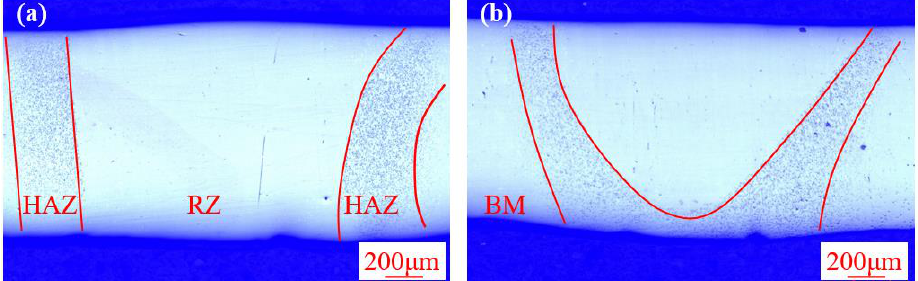
Figure 3. The cross-section morphology of the electron beam remelted Zr-based bulk metallic glasses (BMG) obtained by ( a ) 3 mA/11 mm·s −1 and ( b ) 3 mA/13 mm·s −1 .